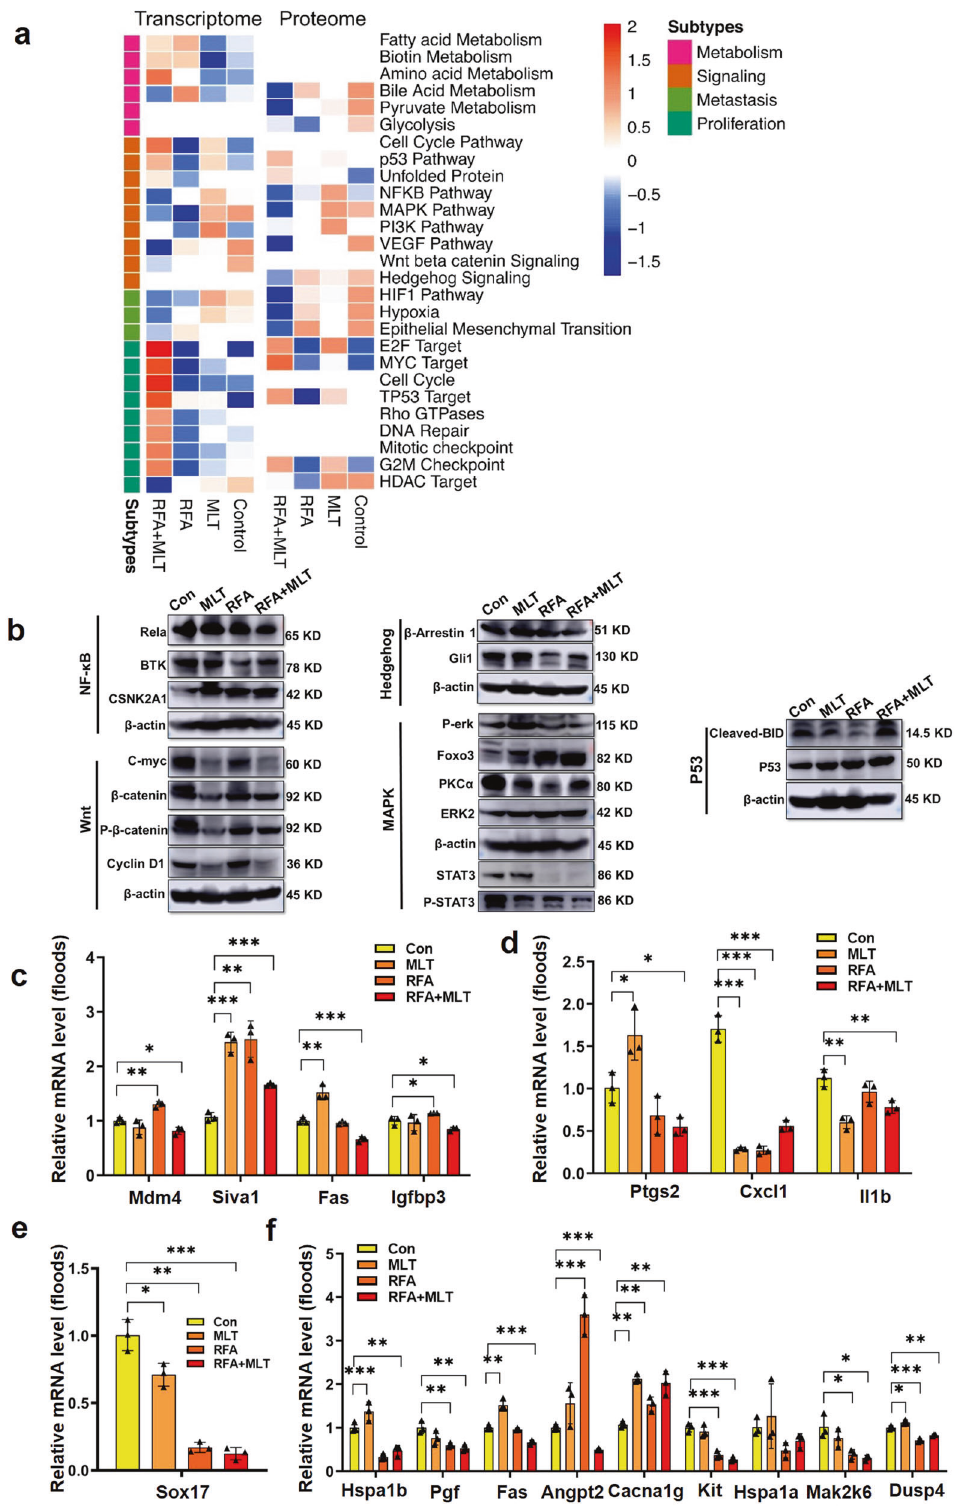
multi-GGNs have several advantages, including side effect management and cost-saving. The combination of RFA and MLT not only wiped off local lung tumor burden via a minimally invasive ablation approach but also effectively reduced prob- ability of multi-GGN enlargement and malignant transformation